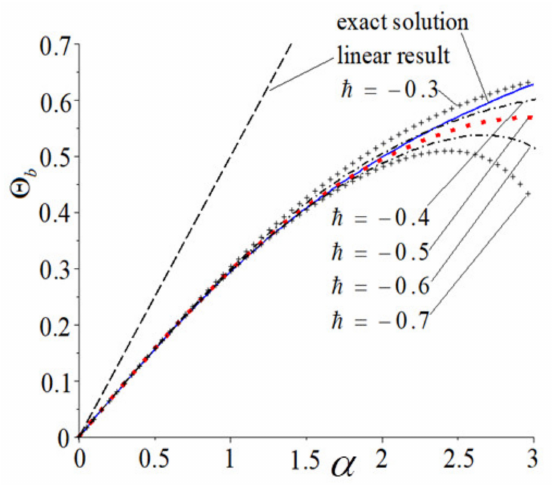
Figure 3. Rotation angle at free end vs. point force when ћ takes different